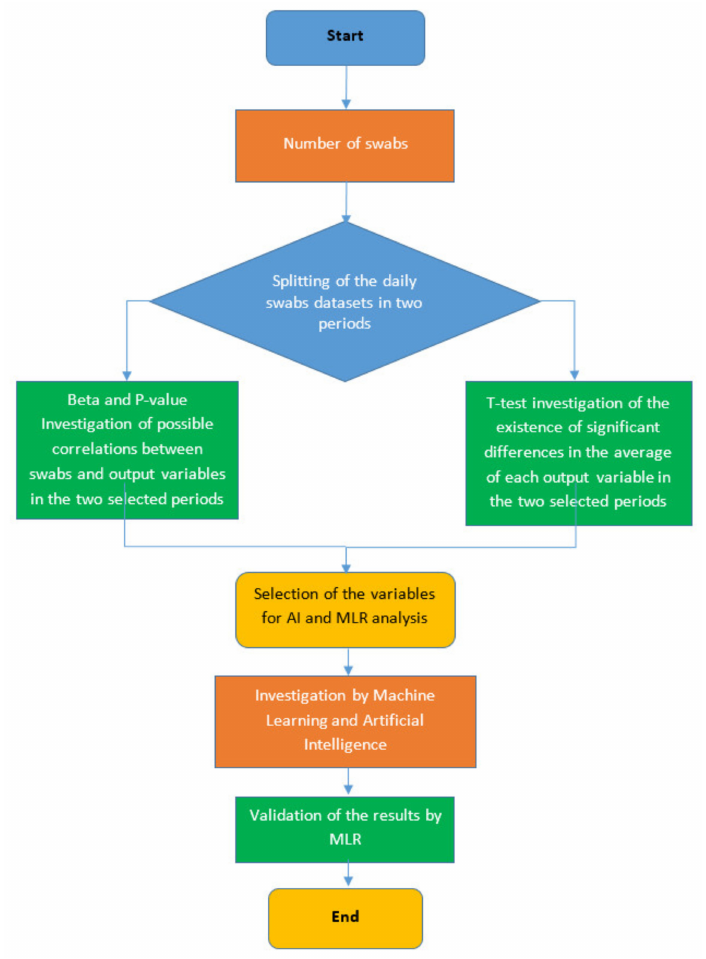
Figure 1. The analysis